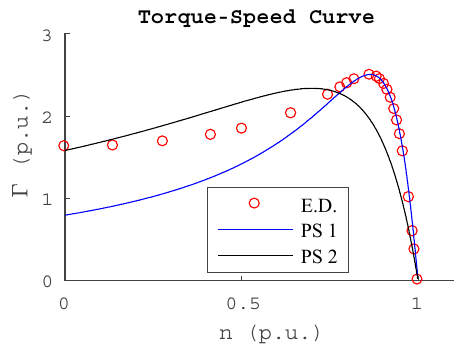
Figure 2. Torque–speed curves with two sets of parameters, PS 1 and PS 2, and experimental data (E.D.) of an IM.